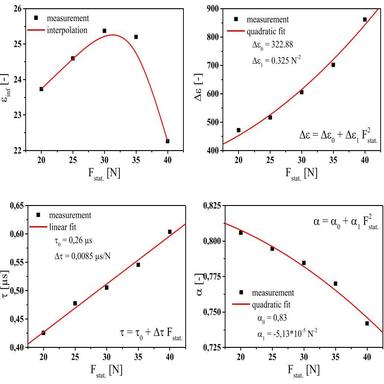
Static load dependence of the Cole-Cole fit parameters (εinf, Δε, τ, α) of the SBR sample.